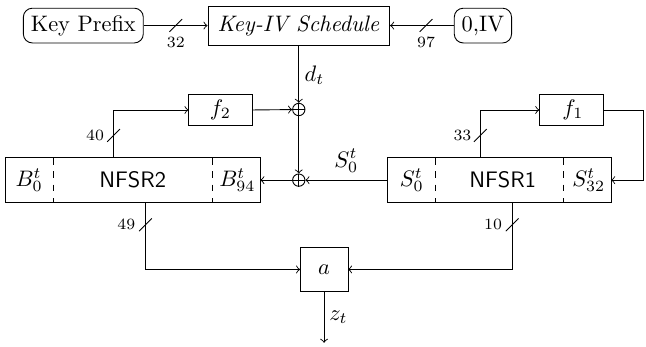
Figure 1: Draco in keystream generation